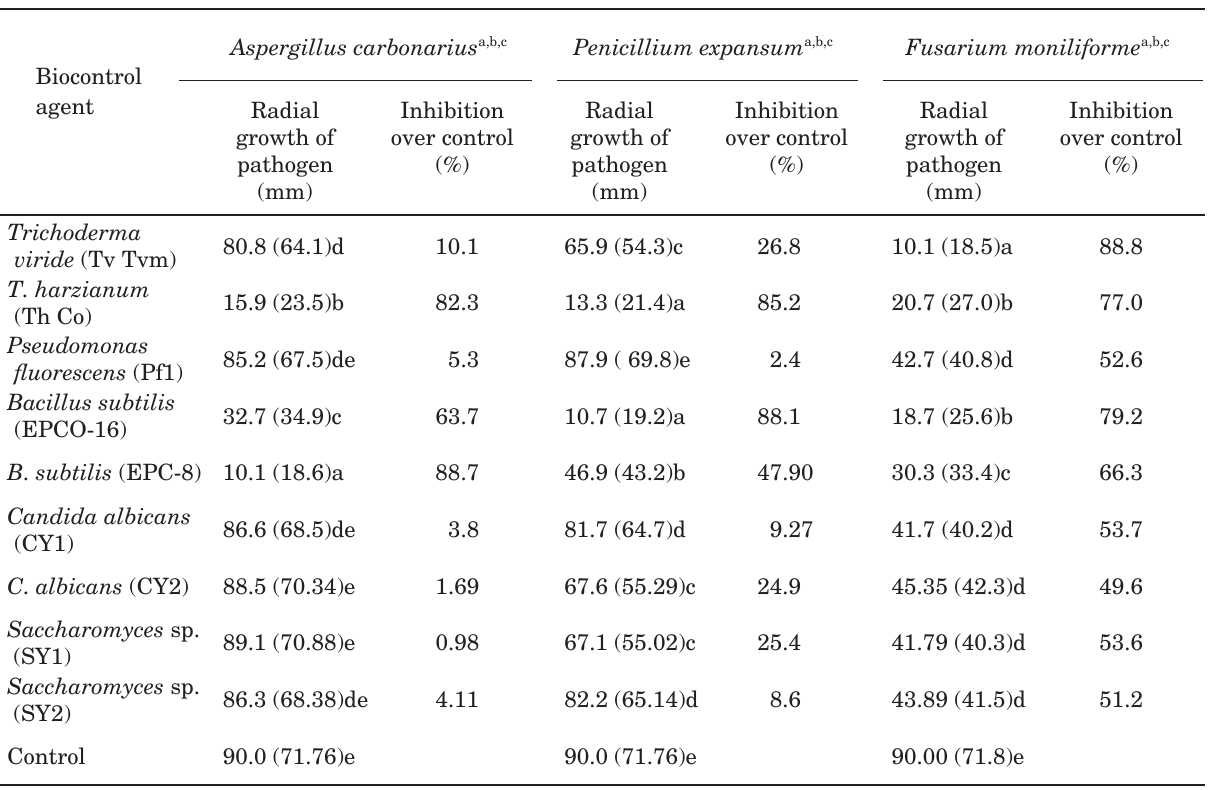
Table 1. Efficacy of biological agents on postharvest pathogens of grapes in